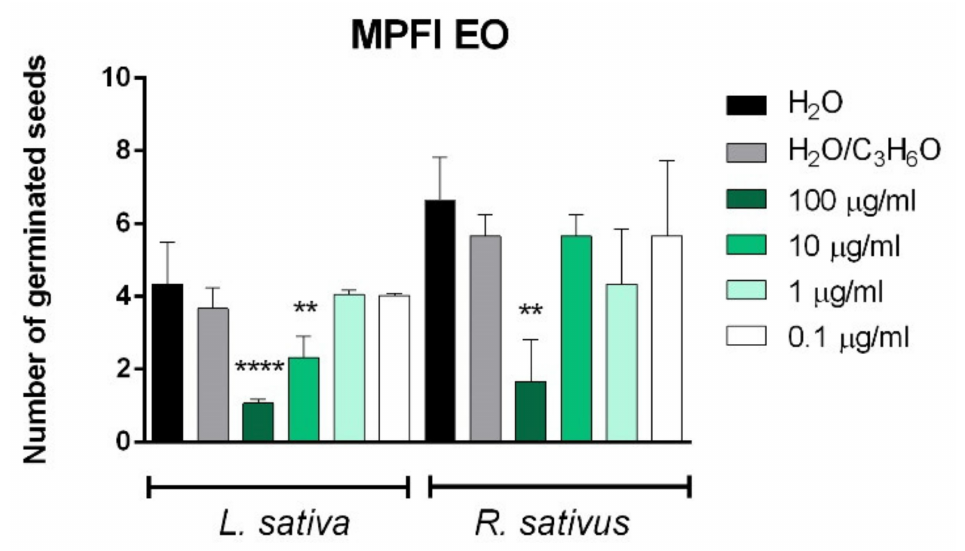
Figure 6. Phytotoxic activity of M. pulegium leaves (MPLI) and flowers (MPFI) EOs against germina- tion of P. oleracea , and radical elongation of L. sativa and R. sativus 120 h after sowing. Results are the mean of three experiments ± standard deviation. ** p < 0.01, **** p < 0.0001 compared with control (ANOVA followed by Dunnett’s multiple comparison